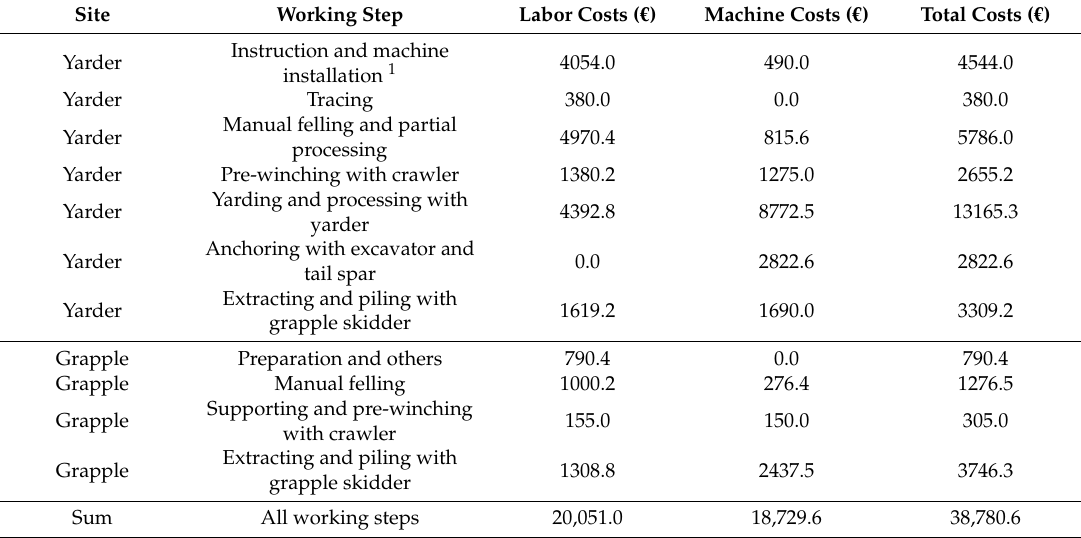
Table 6. Resulting labor, machine, and total costs of the di ff erent working steps in the cable-based FO, in €